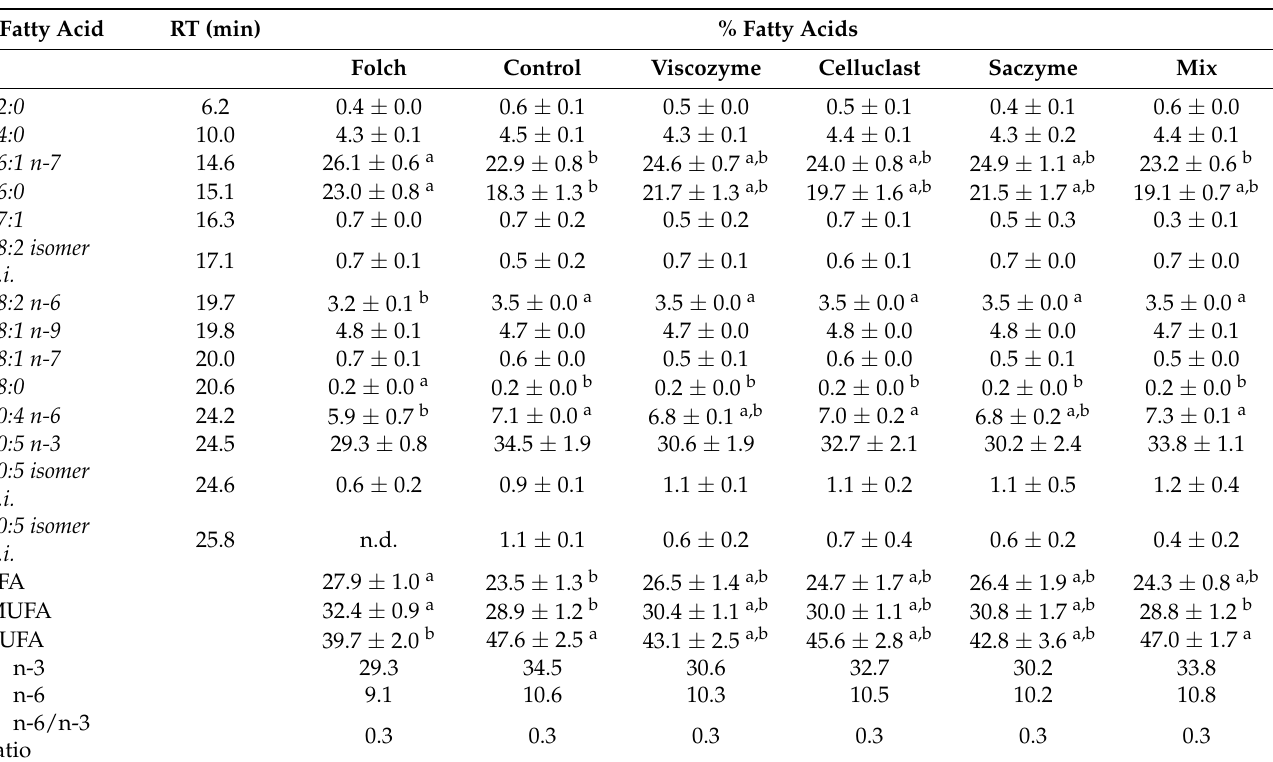
Table 1. Fatty acid composition determined by GC–MS of the lipid extracts obtained from Nan- nochloropsis gaditana comparing different extraction